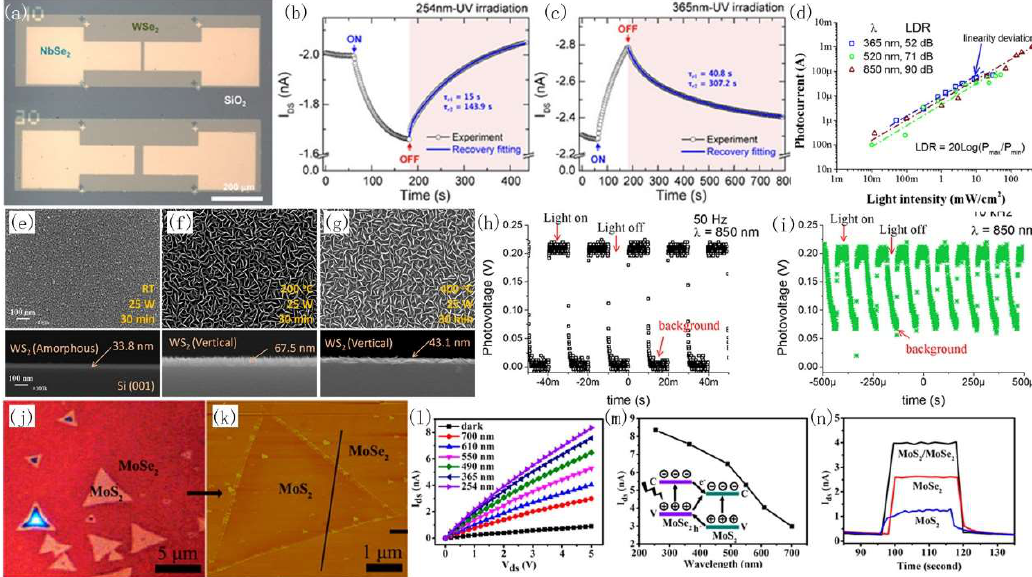
Figure 6. Synthesized junction-type photodetector. ( a ) Optical image and ( b , c ) transient photoresponse of WSe 2 /NbSe 2 heterojunction on exposure to ultraviolet (UV) light with 254 nm and 365 nm wavelength of the WSe 2 /NbSe 2 heterojunction device [83]; ( d ) Linear dynamic range extracted from the photocurrent versus light intensity curve of the WS 2 /Si heterojunction [143]; ( e – g ) Topographical and cross-sectional SEM image of WS 2 sample with different growth temperatures [143]; ( h , i ) Transient photovoltage of WS 2 /Si heterojunction photodetector with pulse light of 850 nm at 50 Hz and 10 kHz respectively [143]; ( j ) Optical and ( k ) AFM image of MoS 2 /MoSe 2 heterojunction photodetector [146]. Current versus ( l ) drain bias and ( m ) wavelength; and ( n ) time-resolved photo response of MoS 2 , MoSe 2, and MoS 2 /MoSe 2 photodetectors